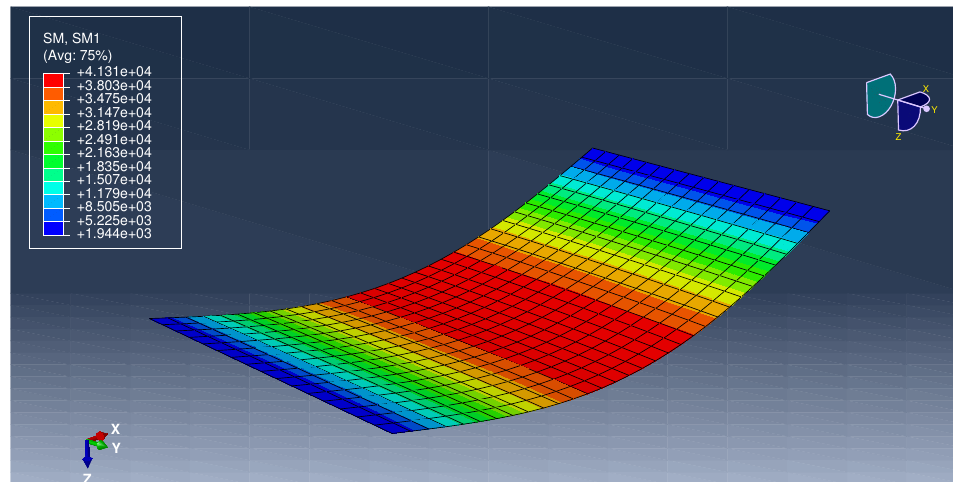
Figure A2. The bending moment M 11 of a rectangular plate with two opposite edges simply supported and the other free solved using FEM.